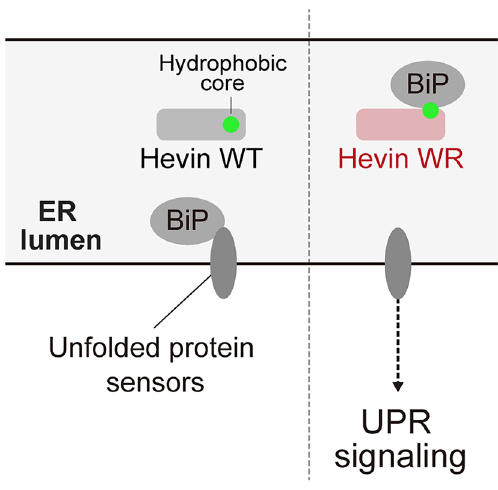
Figure 5. Model describing the dynamics of Hevin WT and WR mutant in the ER. BIP associates with Hevin WR mutant and triggers the UPR